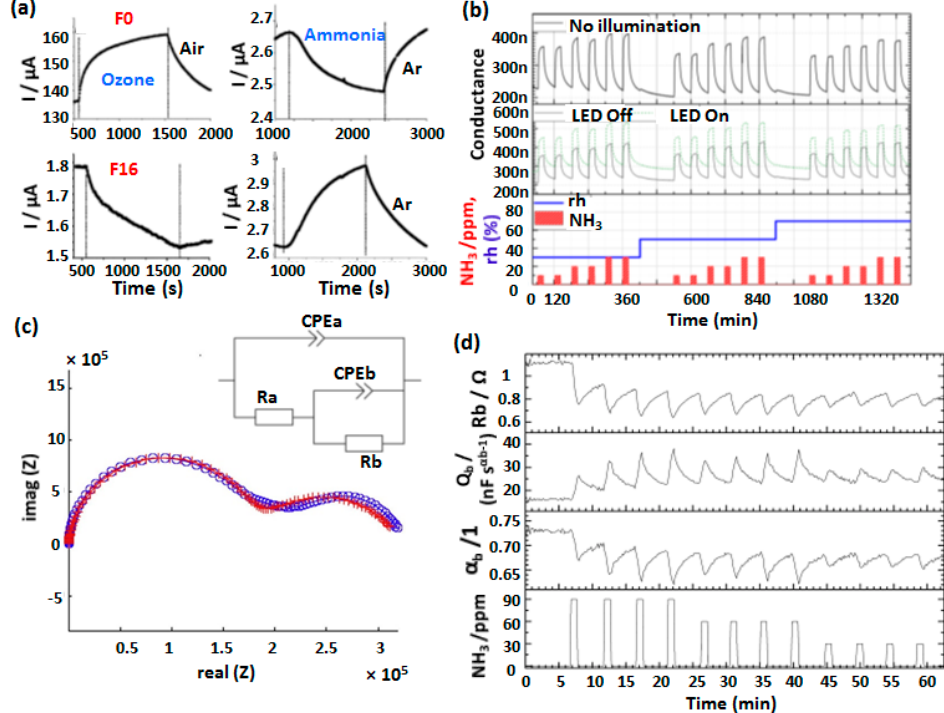
Figure 11. Current variations of CuPc / LuPc 2 and Cu(F 16 Pc) / LuPc 2 MSDI under exposure to 90 ppb of ozone and 35 ppm of NH 3 ( a ). (adapted from [20]) Variations of conductance in dark (upper row) and with light (middle row) at different NH 3 (red bars) and rh (blue line) levels ( b ) [71]. The Nyquist diagram of Cu(F 16 Pc)/LuPc 2 MSDI representing variation of real and imaginary impedances ( c ) and the equivalent impedance circuit (inset of c). The variations of interfacial charge transfer coefficient ( α ) and other impedance circuit parameters as a function of NH 3 concentrations ( d ) [47].